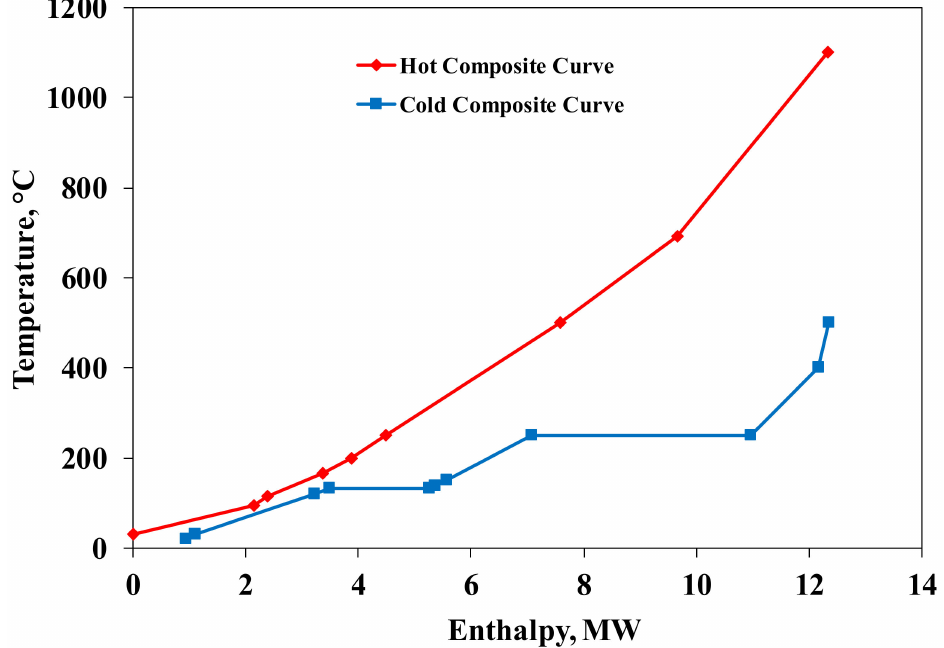
Figure 8. Hot and cold composite curves for base case simulation PAPS